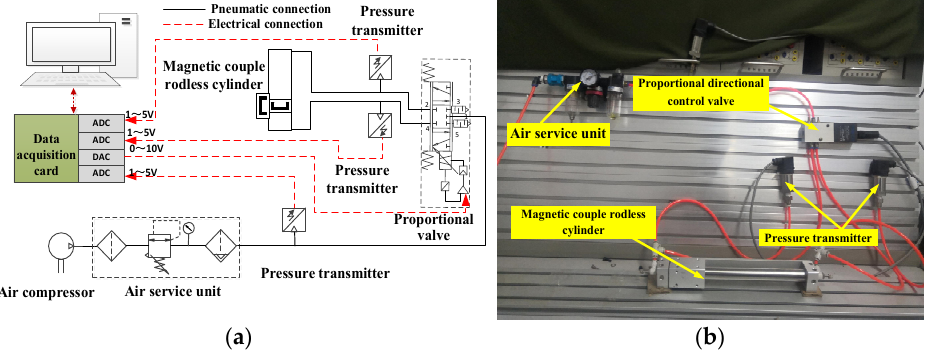
Figure 17. Air-filling experiment diagram of fixed chamber: ( a ) experimental principle; ( b ) experimental test platform.